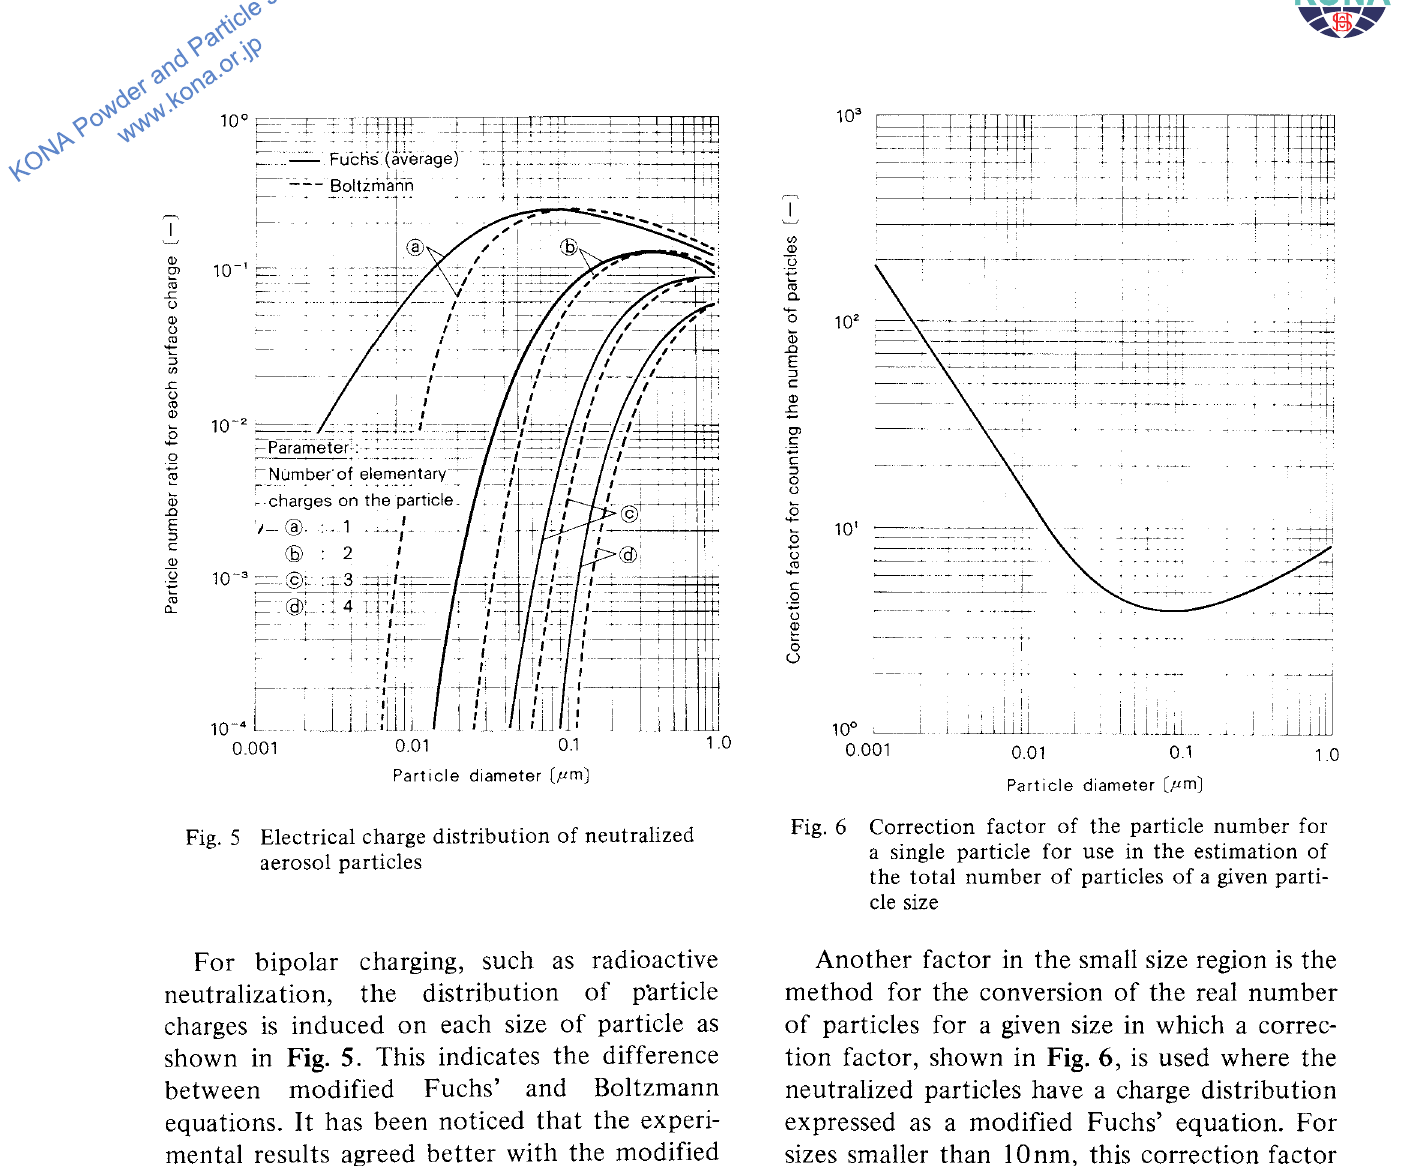
Fig. 6 Correction factor of the particle number for a single particle for use in the estimation of the total number of particles of a given parti cle